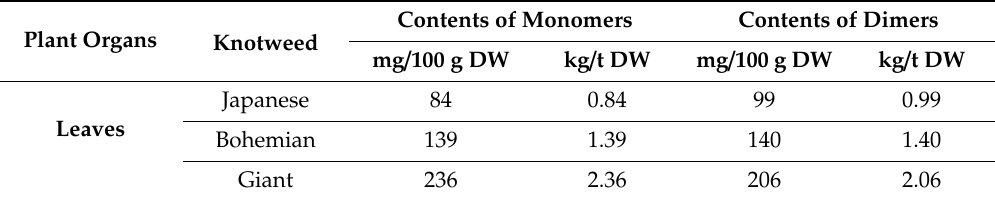
Table 2. Contents of monomers and dimers in leaves of Japanese, Bohemian and giant knotweed, expressed per dry weight (DW) of the plant material, were quantified based on ( − )-epicatechin and procyanidin B2 calibration curves, respectively.